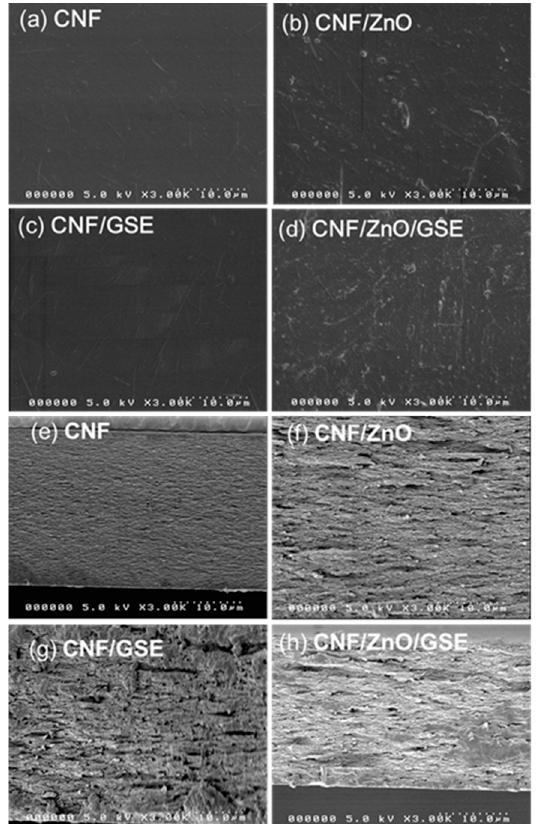
Figure 2. FESEM surface ( a – d ) and cross-sectional ( e – h ) images of the neat cellulose nanofiber (CNF) and CNF/ZnO/grapefruit seed extract (GSE) nanocomposite